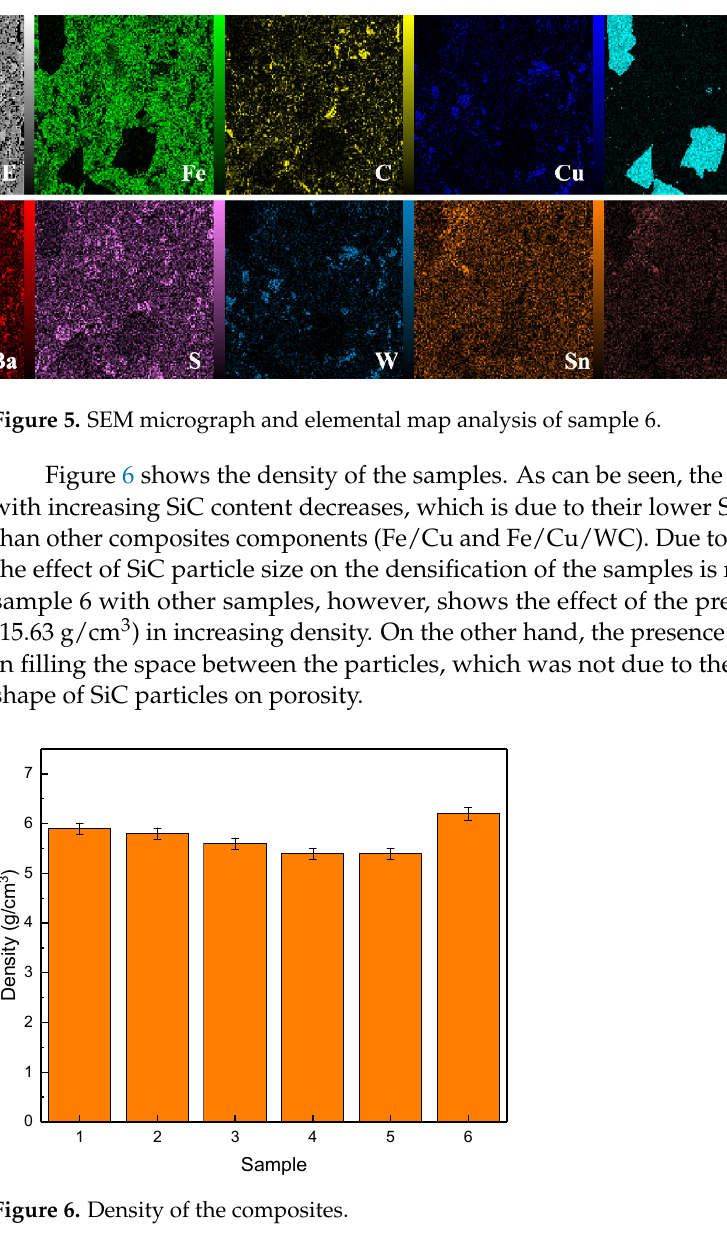
Figure 6. Density of the composites.